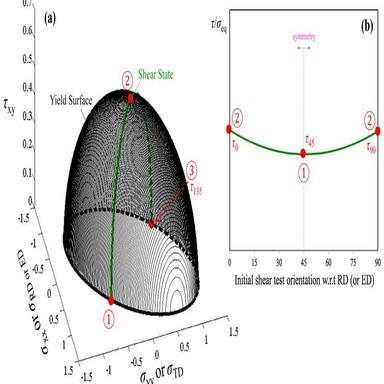
5. Schematic views of (a) top half of a yield surface plotted in 3-D in which the shear region is shown in green, and (b) variation of shear yield stress with direction for an orthotropic material.